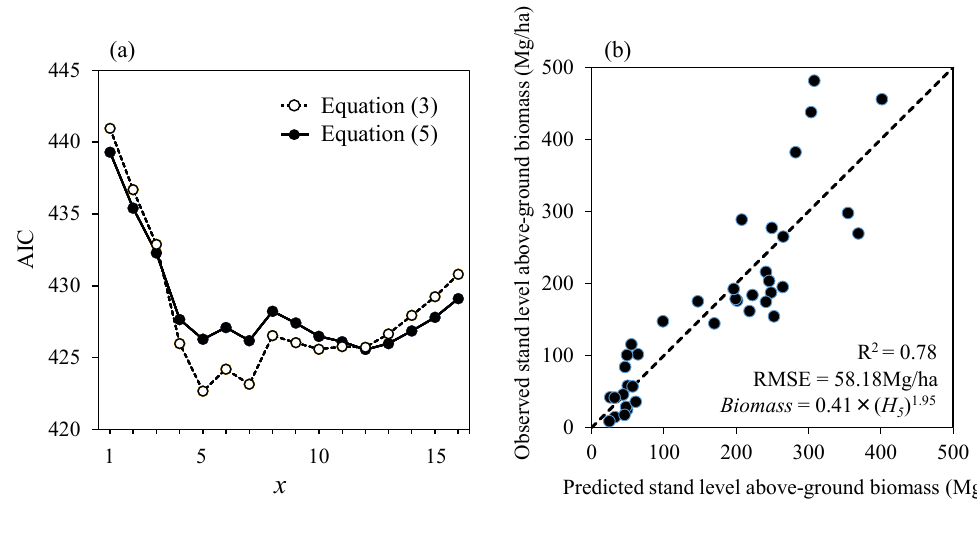
Figure 6. Result of regression analysis for mean tree height of the tallest x trees in each plot: ( a ) AIC ( x from one to 16); ( b ) Observed and predicted biomass estimation for the best model ( x =